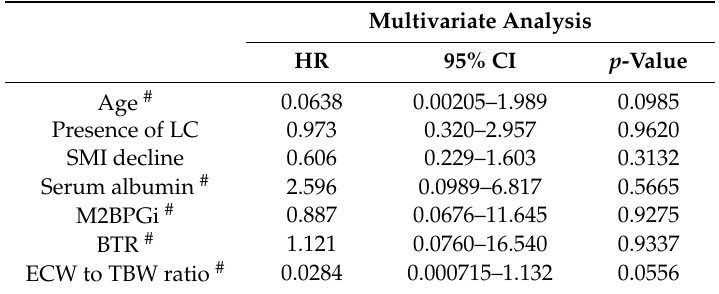
Table 6. Multivariate analyses of factors linked to walking speed decline ( < 1.0 m / s).